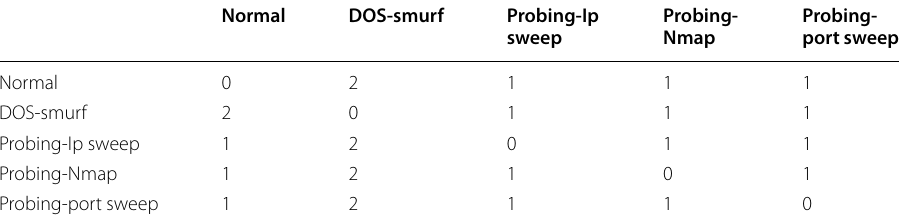
Table 6 Cost matrix given by challenge organizers [13] Normal DOS-smurf Probing-Ip Probing- Probing- sweep Nmap port sweep Normal 0 2 1 1 1 DOS-smurf 2 0 1 1 1 Probing-Ip sweep 1 Probing-Nmap 1 Probing-port sweep